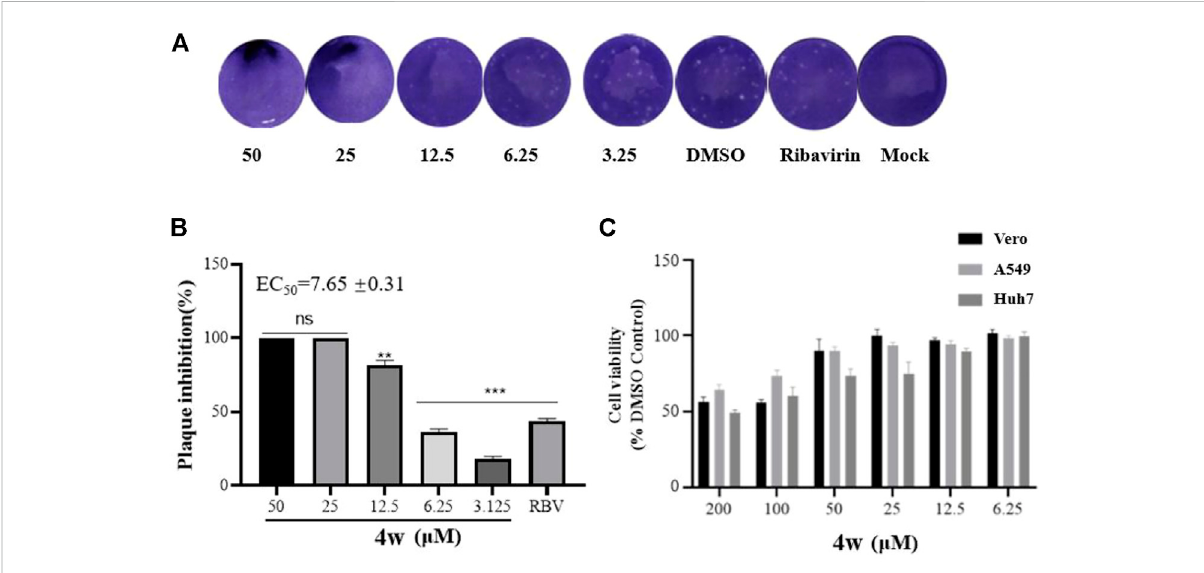
FIGURE 2 Compounds 4w inhibited the plaque formation caused by ZIKV infection, Vero cells were infected with ZIKV (MOI = 0.1) at 37 ° C for 2 h. (A) Original graph of 4w inhibiting ZIKV plaque formation; (B) 4w inhibition rate of ZIKV-induced plaque formation; (C) 4w cytotoxicity to Vero, Huh7, and A549 cells, data is the mean (±SD) of three experiments, with DMSO as a positive control, and Ribavirin = 50 μ M as a positive drug control. * p < 0.05; ** p < 0.01; *** p < 0.001.